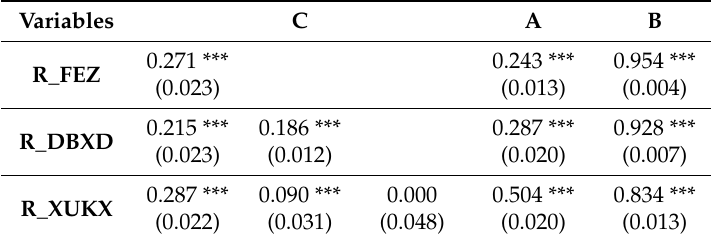
Table 15. Diagonal BEKK for Europe Market ETF returns (After GFC) (1 April 2009 to 30 March